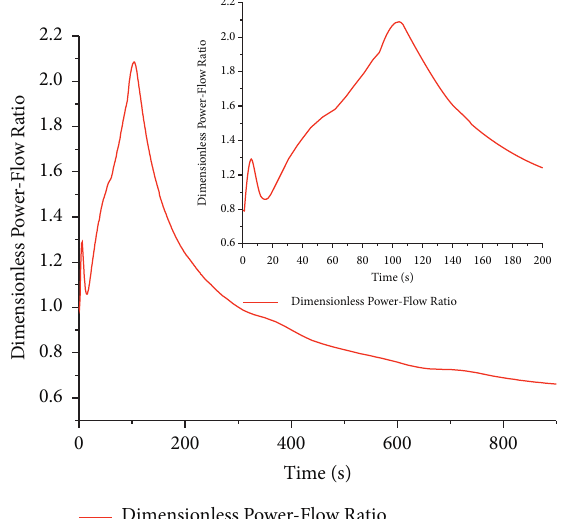
Figure 23: Dimensionless power-flow